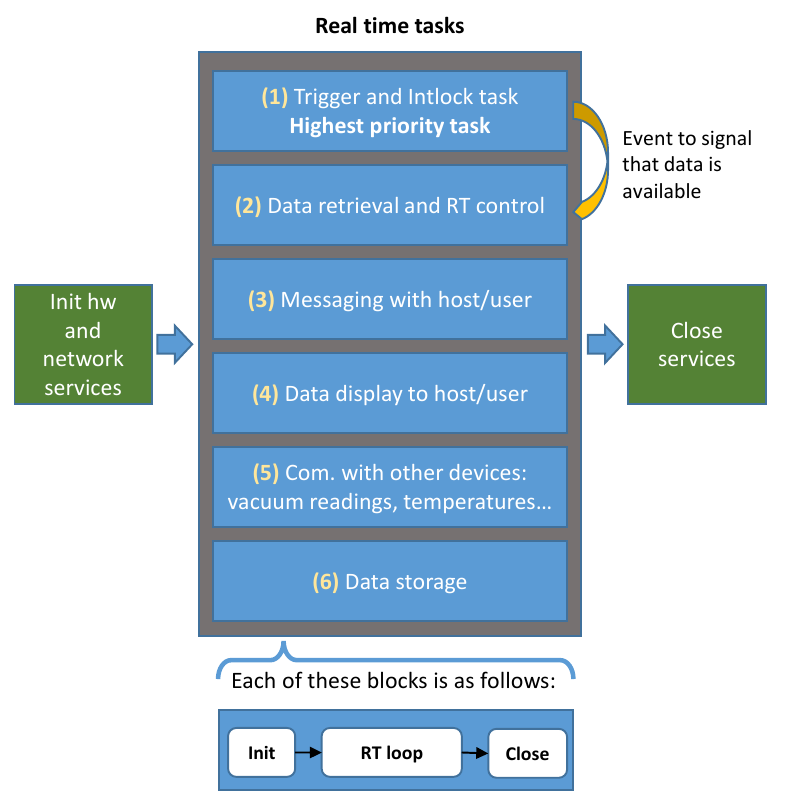
Figure 13. General structure of the code in the real-time system.